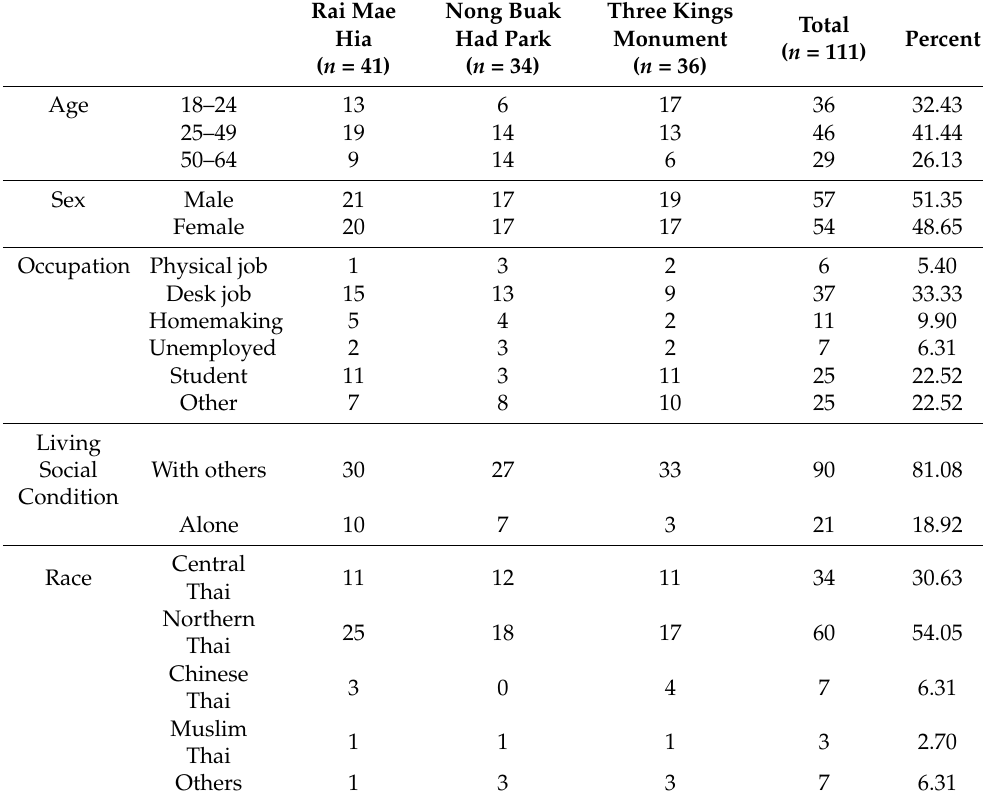
Table 1. The demographics of the participants across the study